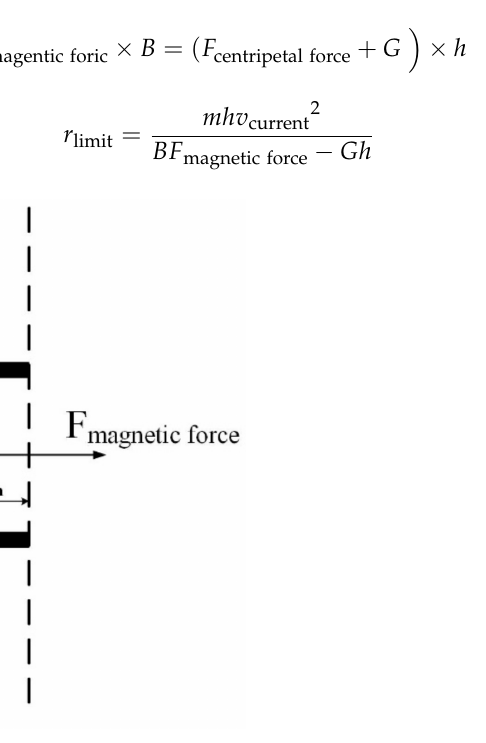
Figure 13. The robot is about to overturn.